Question: Describe this figure in one sentence.
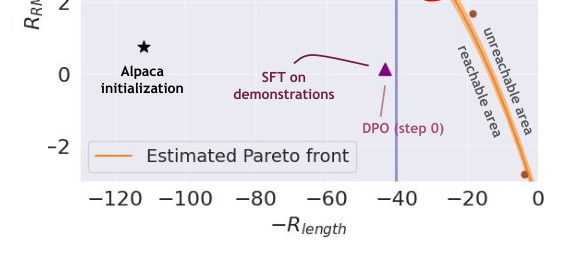
Answer: The Pareto front emerges when optimizing RRM and -Rlength for the summarization task. This front is delineated by varying the balancing weight α in Rα and using PPO. Notably, the average coordinate of the demonstration rewards is located on this front. RCfD facilitates the direct targeting of this coordinate.